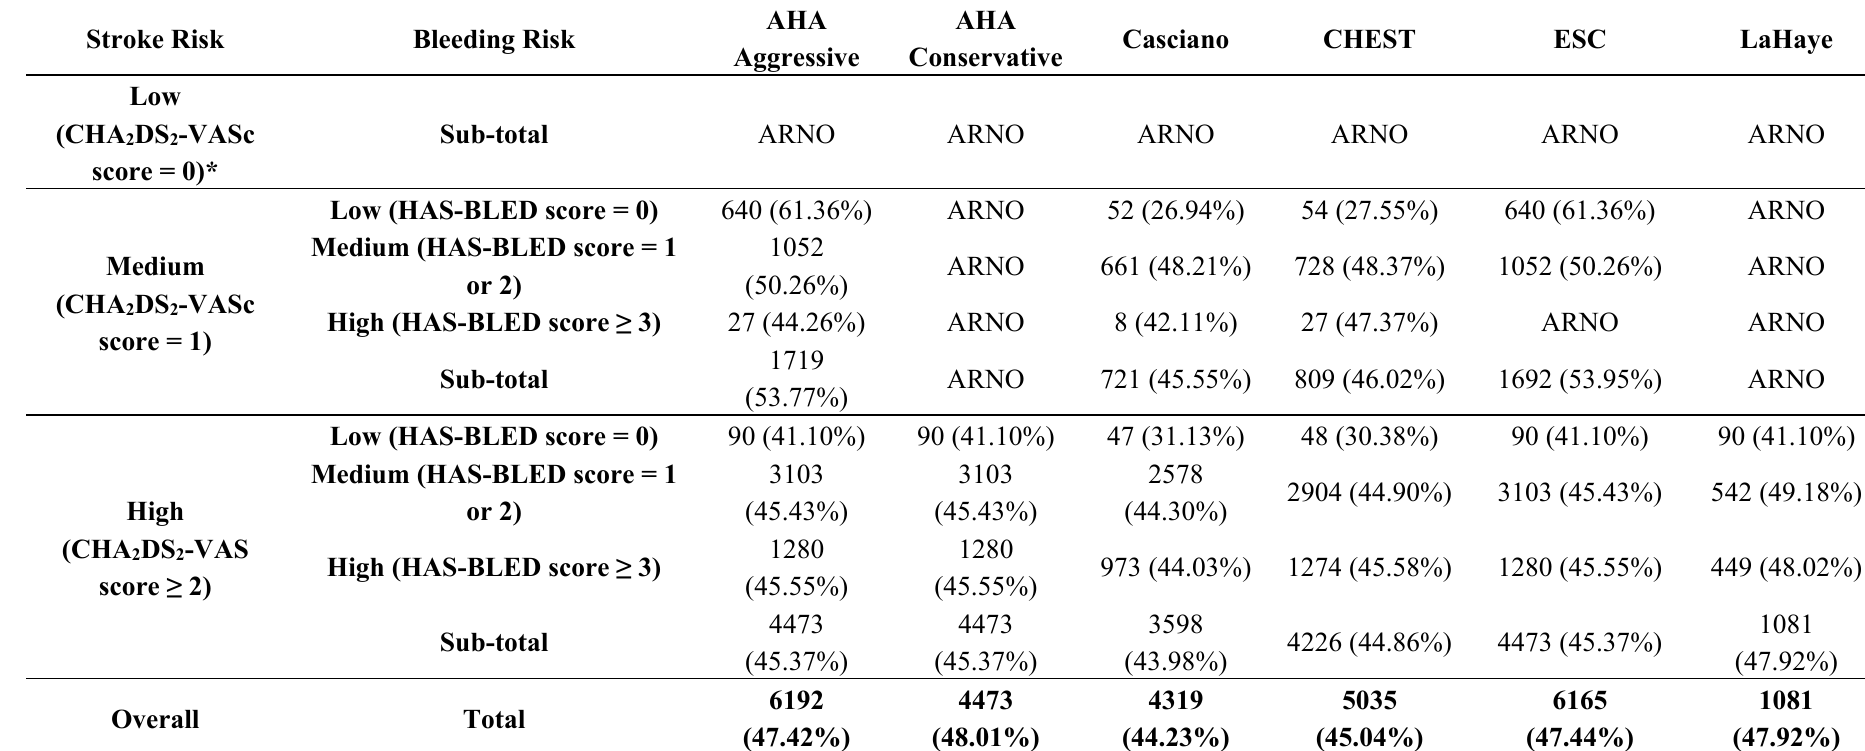
Table 3. Underuse of OAC (Number of patients discordant with the OAC treatment recommendation by decision aids). Stroke Risk Bleeding Risk